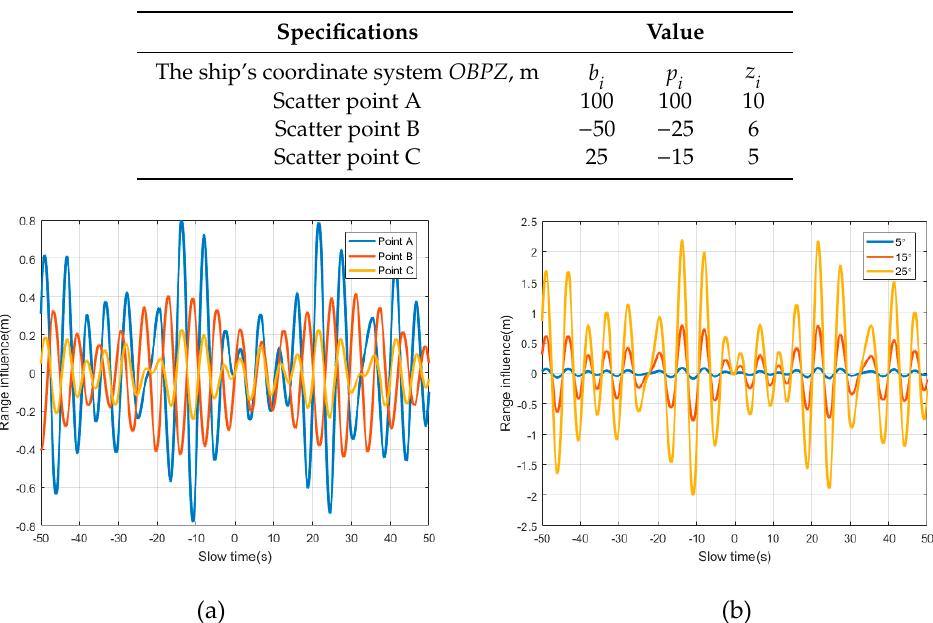
Table A2. The parameters of the positions of scatter points.